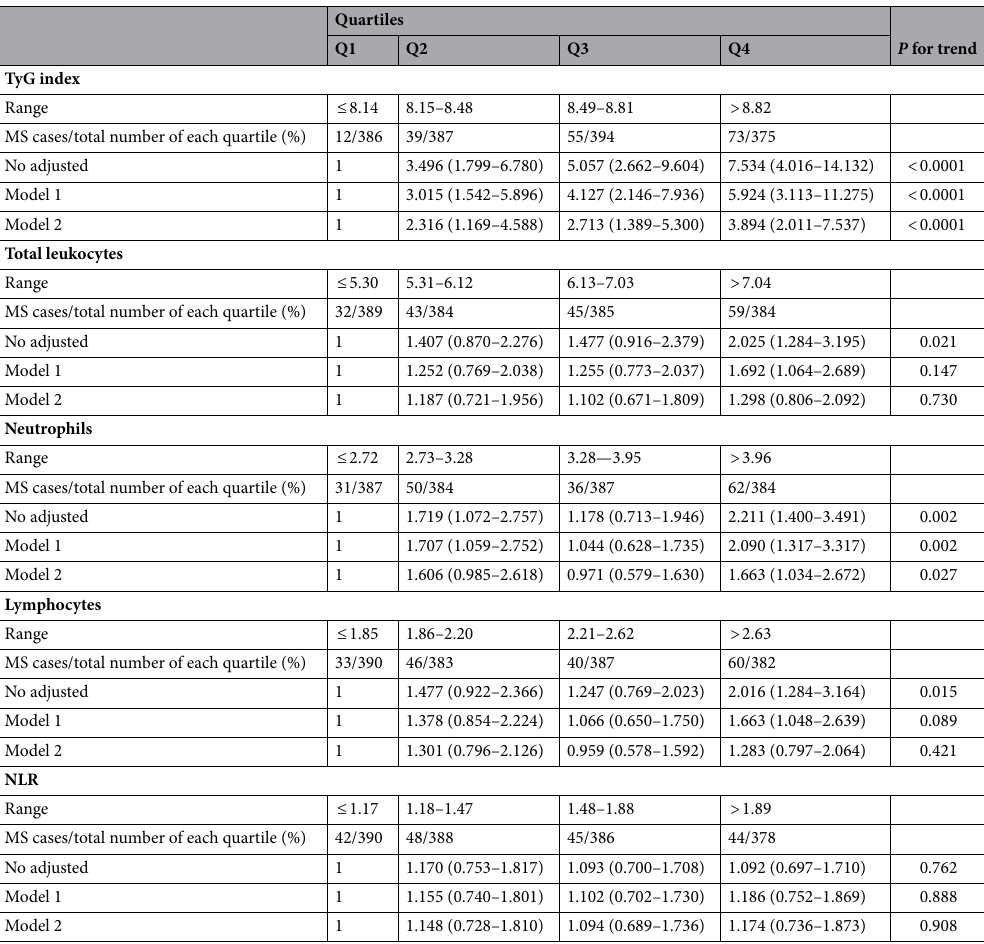
Table 2. Associations of TyG index, inflammatory markers and risk of metabolic syndrome incidence (odds rations and 95% confidence intervals). Data are expressed as ORs (95% CI). Model 1: adjusted for age, sex, smoking; model 2: Model 1 adjusted further for body mass index, blood pressure.